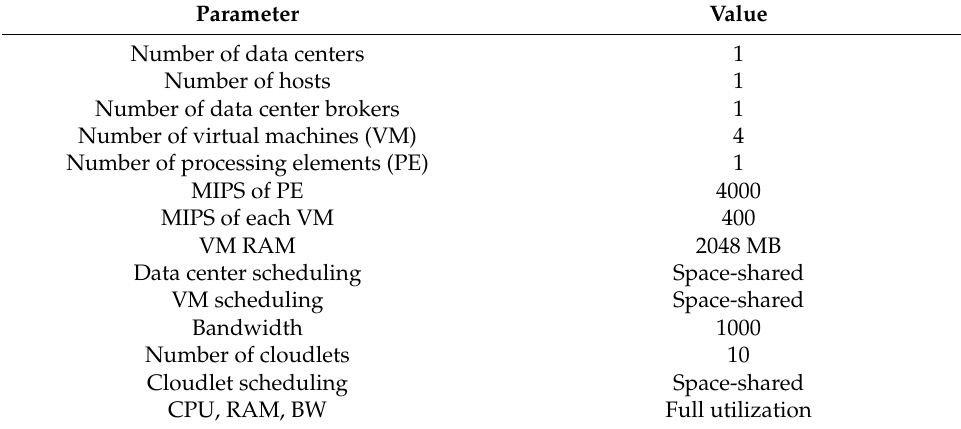
Table 3. CloudSim simulation